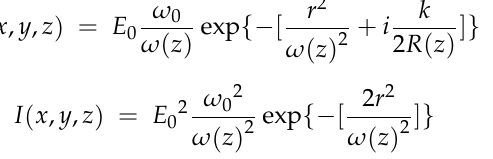
(cid:113) 1 + z 2 / z 2 ), ω 0 is the minimum value 0